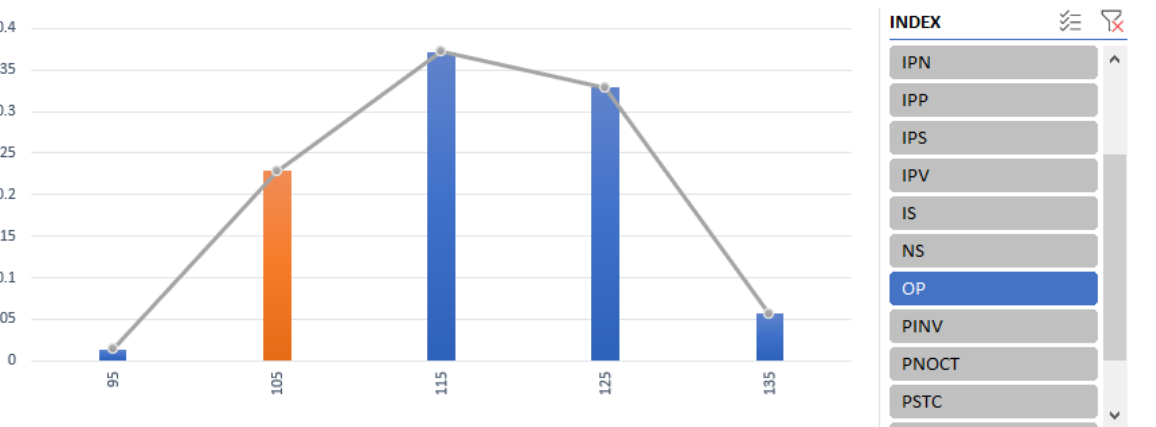
versus . Figure 18. Graphical representation of D E versus D PW . 𝐷𝐷 𝐸𝐸 𝐷𝐷 𝑃𝑃𝑃𝑃